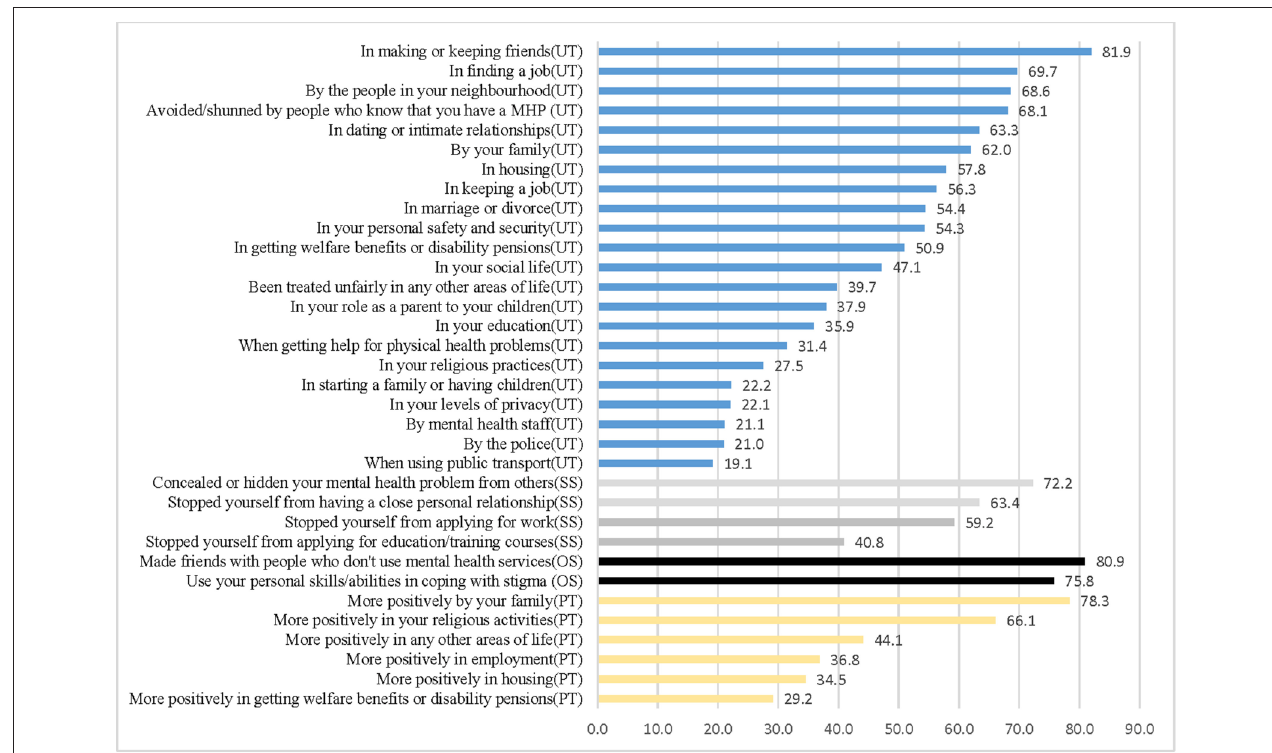
FIGURE 1 | Proportion of agree responses for DISC item. UT, Unfair treatment subscale; SS, Stopping self subscale; OS, Overcoming stigma subscale; PT, Positive treatment subscale; MHP, Mental health problem.